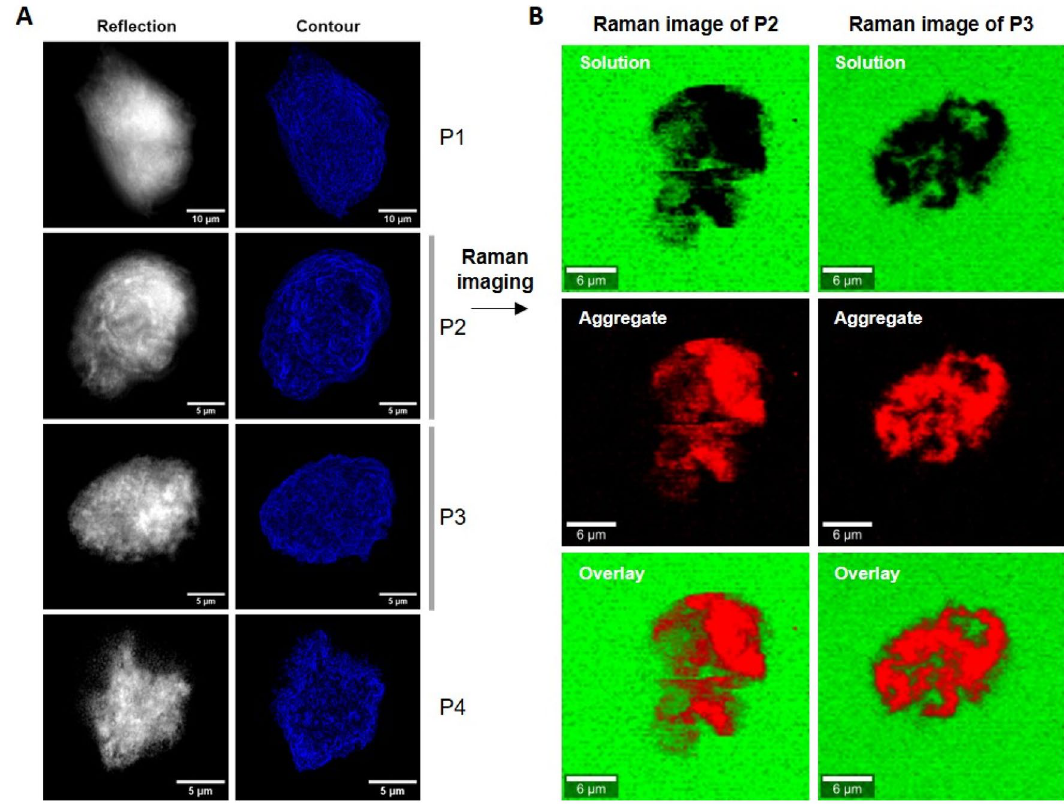
Figure 7. In situ imaging in solution and biochemical analysis of the protein aggregates. ( A ) Optical images using reflected light and contour reconstruction. ( B ) Raman images of the particles P2, P3. Images corresponding to the Raman spectra of the protein aggregate and solution are shown in red and green, respectively. The overlay is shown at the bottom. Two biological replicates were analyzed for each